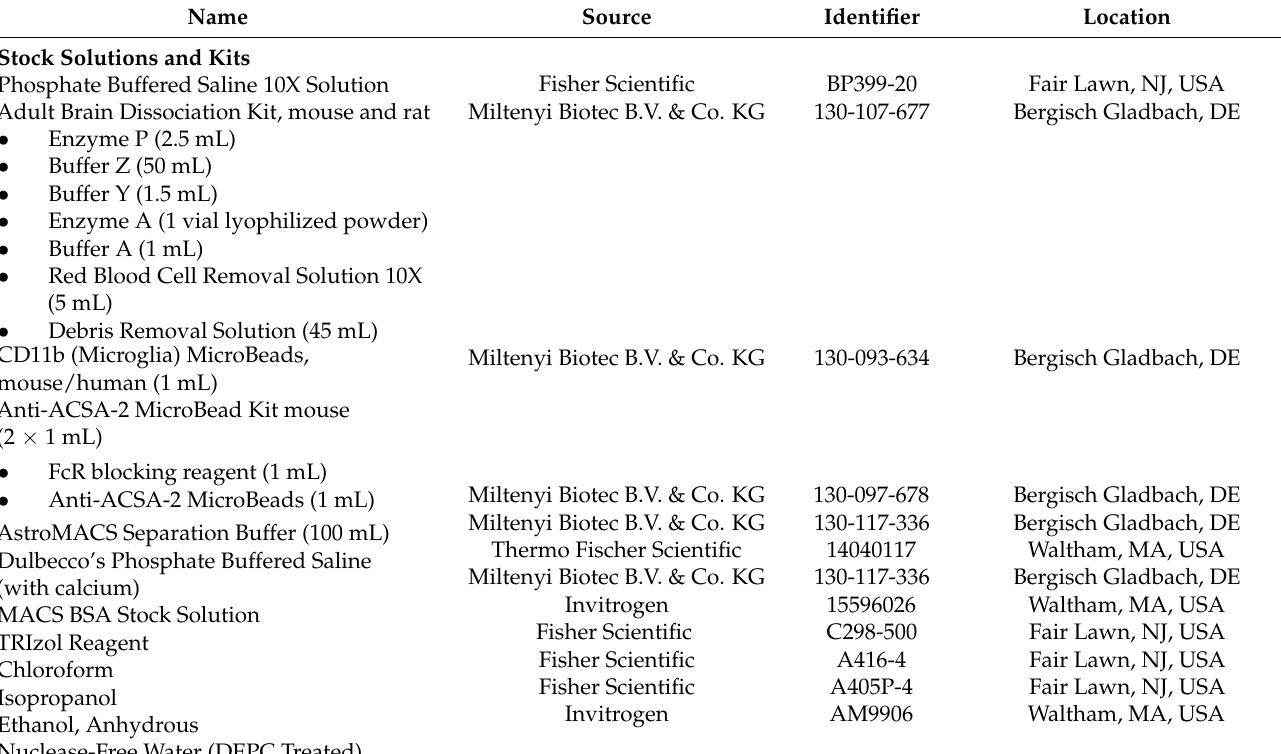
Table 1. Detailed information on required